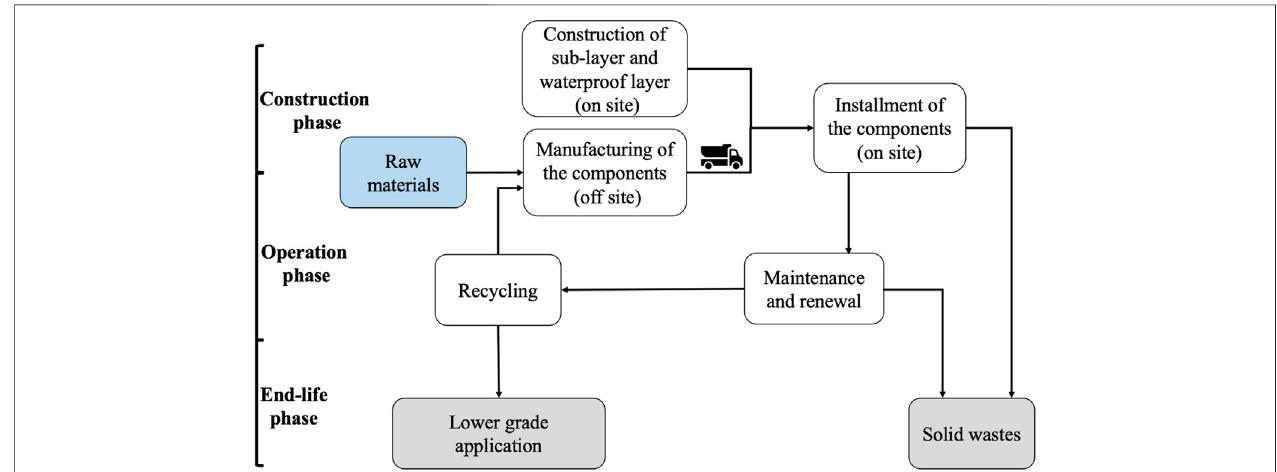
FIGURE 3 | Life cycle stage (adopted from Kiani et al. (2008)).